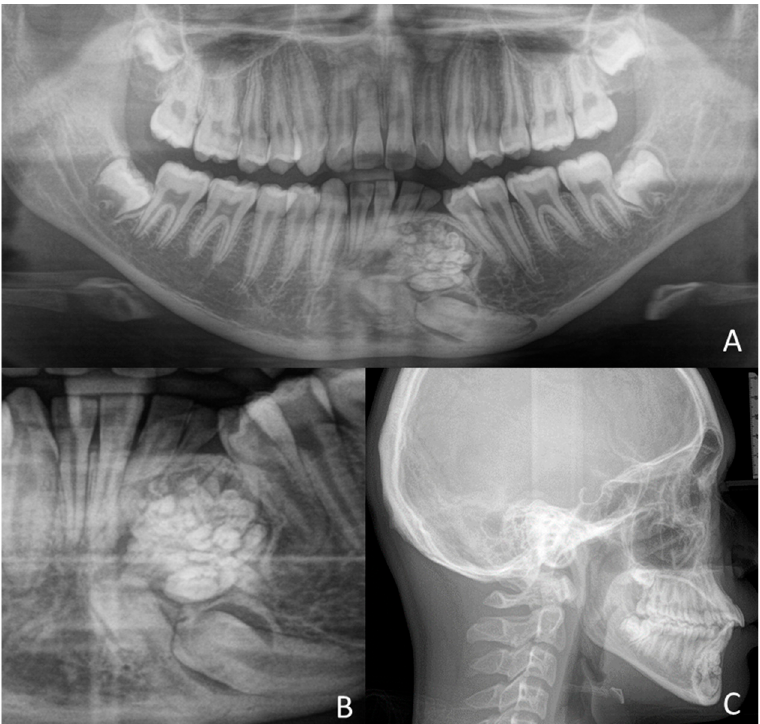
Figure 5. ( A ) Orthopanoramic radiography with the presence of a compound odontoma, formed by many teeth, recognizable on the radiographic image. The maintenance of the deciduous element 72 and the inclusion of the left permanent canine 33 at the lower edge of the mandible. Moreover, mesial to the location of element 33, the presence of element 32 is marked; ( B ) Detail of compound odontoma, the presence of all the teeth forming the new formation; ( C ) Cranial teleradiograph in lateral–lateral projection showing the neoformation, the width of the symphysis is completely occupied by the odontoma.